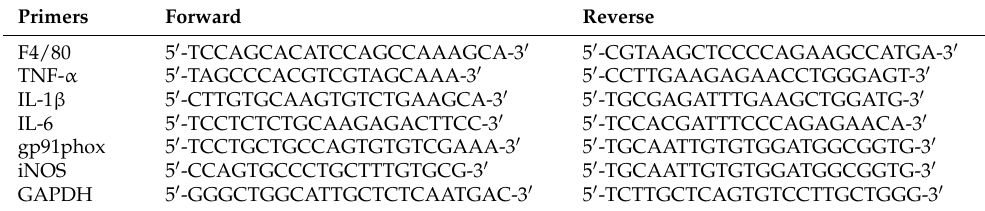
Table 1. Mouse primer sequences for